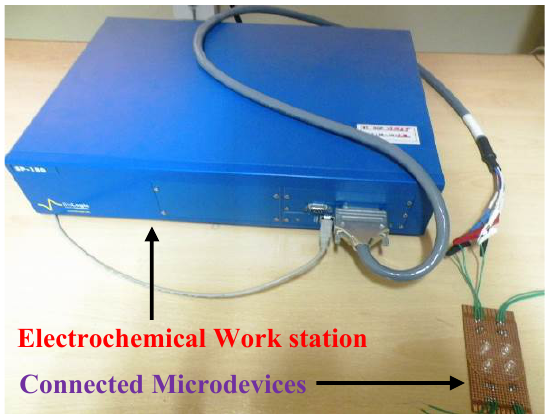
Fig. 2: Test setup for impedance measurement.